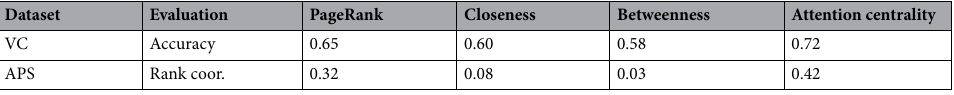
Table 3. Ranking performance comparison between different unsupervised ranking